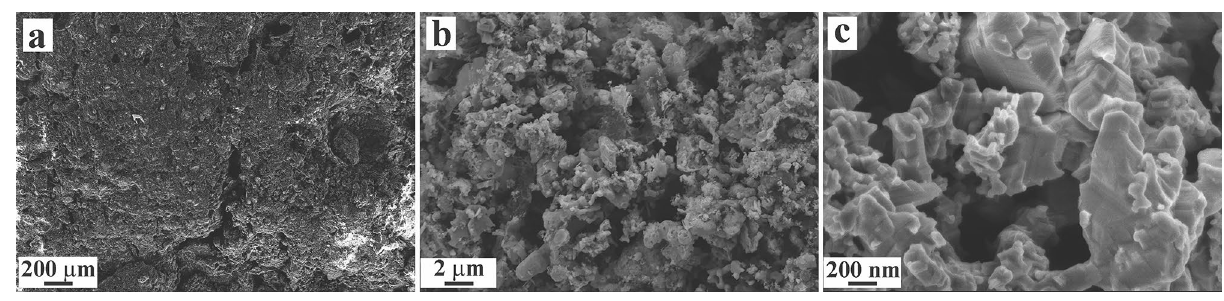
Figure 5. SEM images of the working electrode